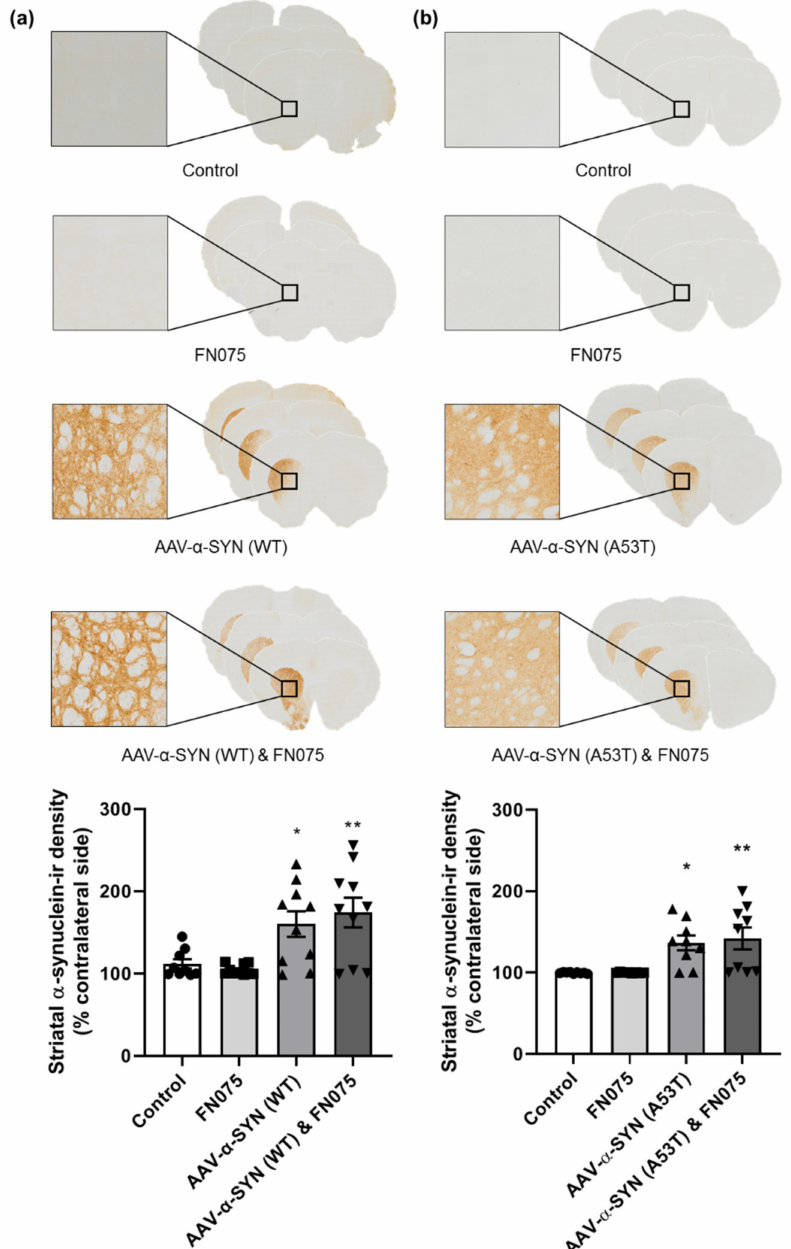
Figure 2. Immunohistological assessment of the impact of the AAV- α -synuclein vectors alone or in combination with FN075 on the expression of human α -synuclein in the striatum. ( a ) AAV- α -SYN (WT) and ( b ) AAV- α -SYN (A53T), either alone or in combination with FN075, caused a significant overexpression of human α -synuclein in the striatum. Data are represented as mean ± SEM with n = 8–10 animals per group. * p < 0.05, ** p < 0.01 vs. Control by one-way ANOVA with post hoc